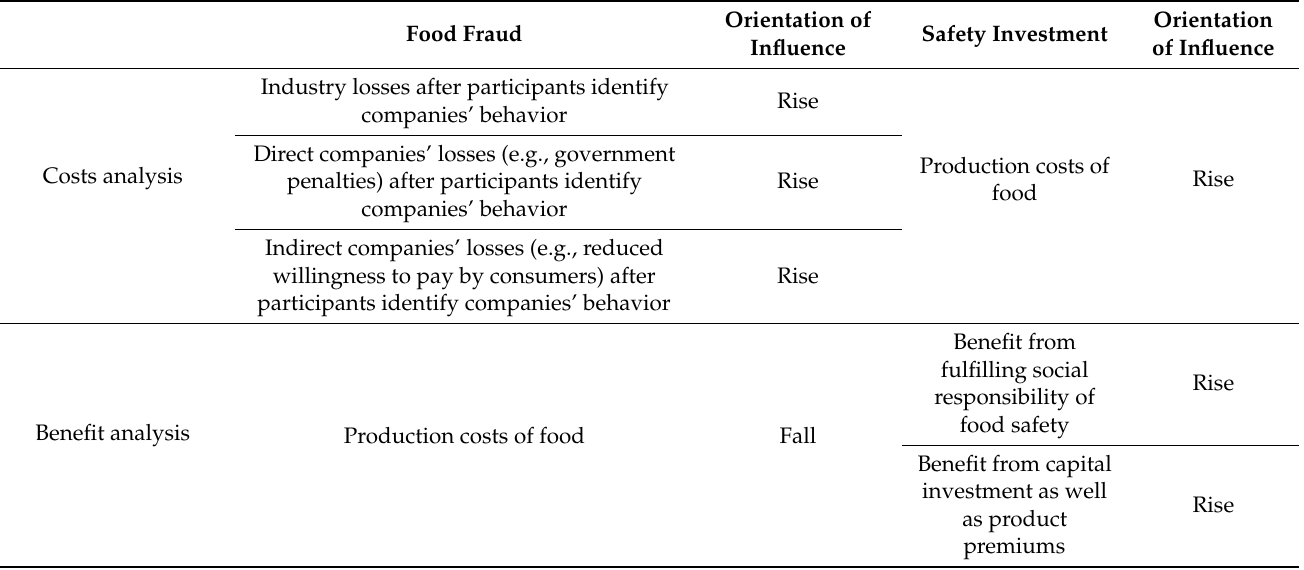
Table 2. Costs and benefit of food safety strategies of companies.